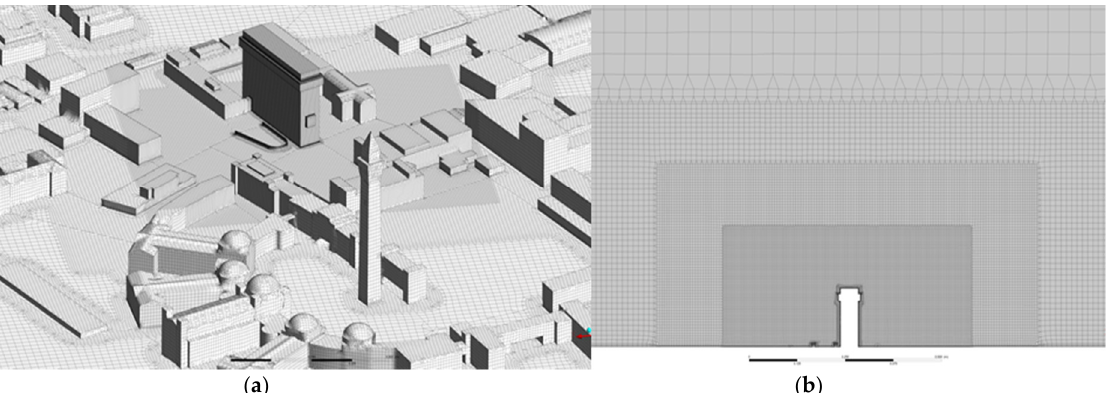
Figure 3. Detail of the computational grid. ( a ) View of the surface mesh of the University Campus and the Biosciences tower; ( b ) view of the volume grid highlighting the refinement regions.